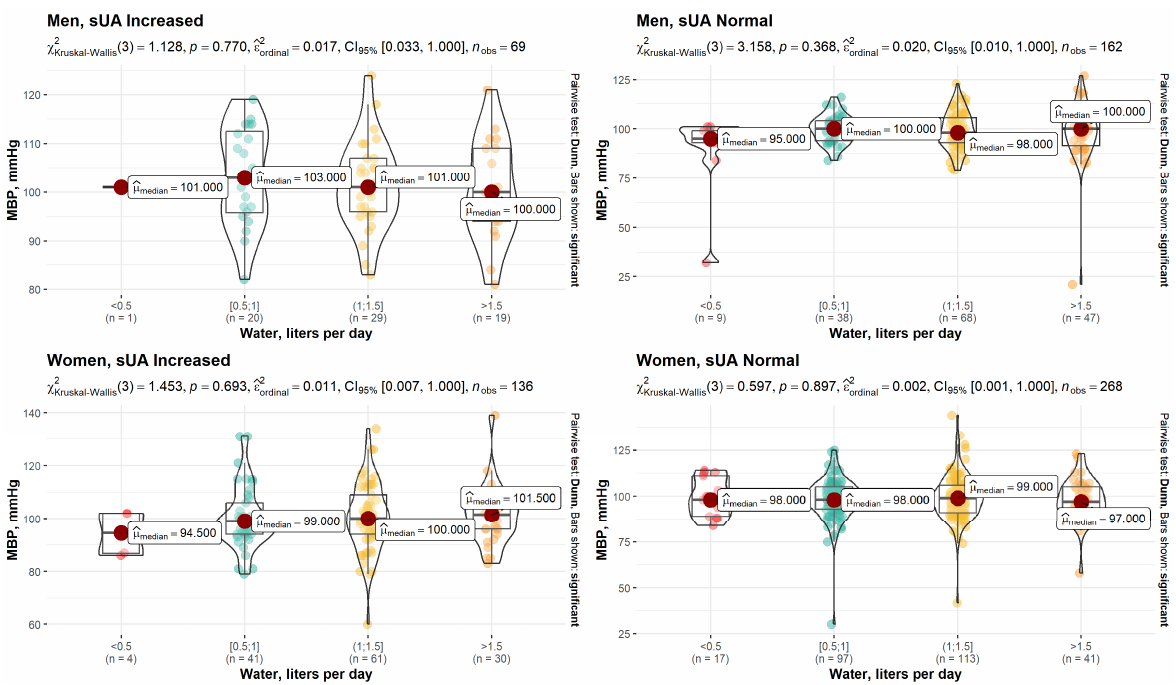
Figure 2. Dependence between water intake habits and MBP in patients with normal and increased sUA levels.